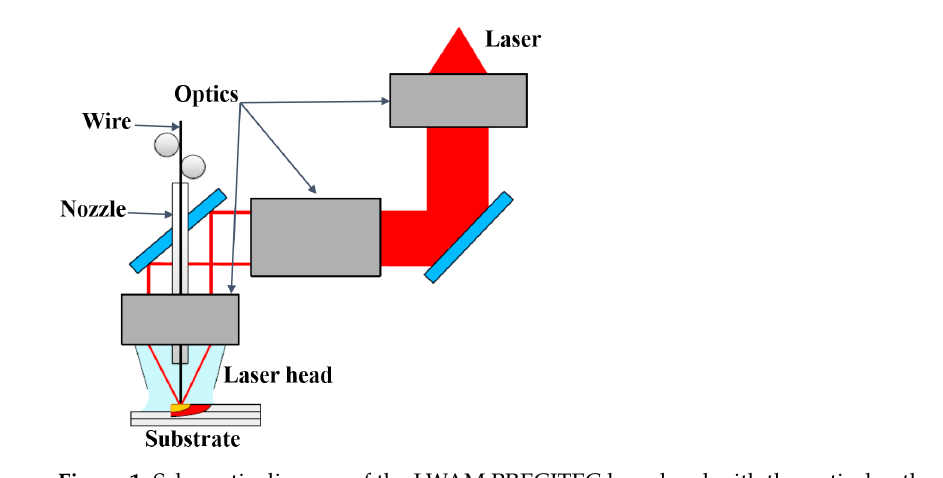
Figure 1. Schematic diagram of the LWAM PRECITEC laser head with the optical path of the laser beam and injection of the filler metal.